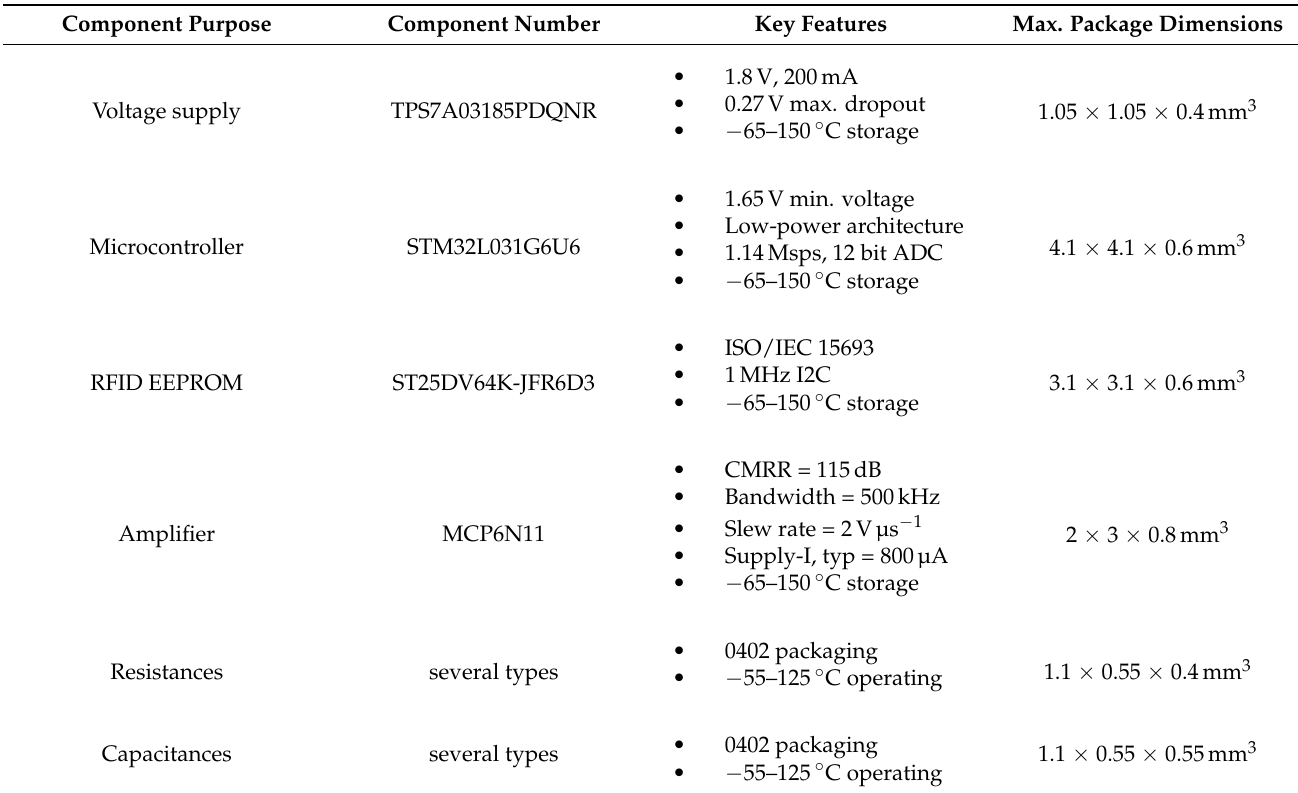
Table 1. Components for a wireless SHM sensor node for GUW based damage detection.